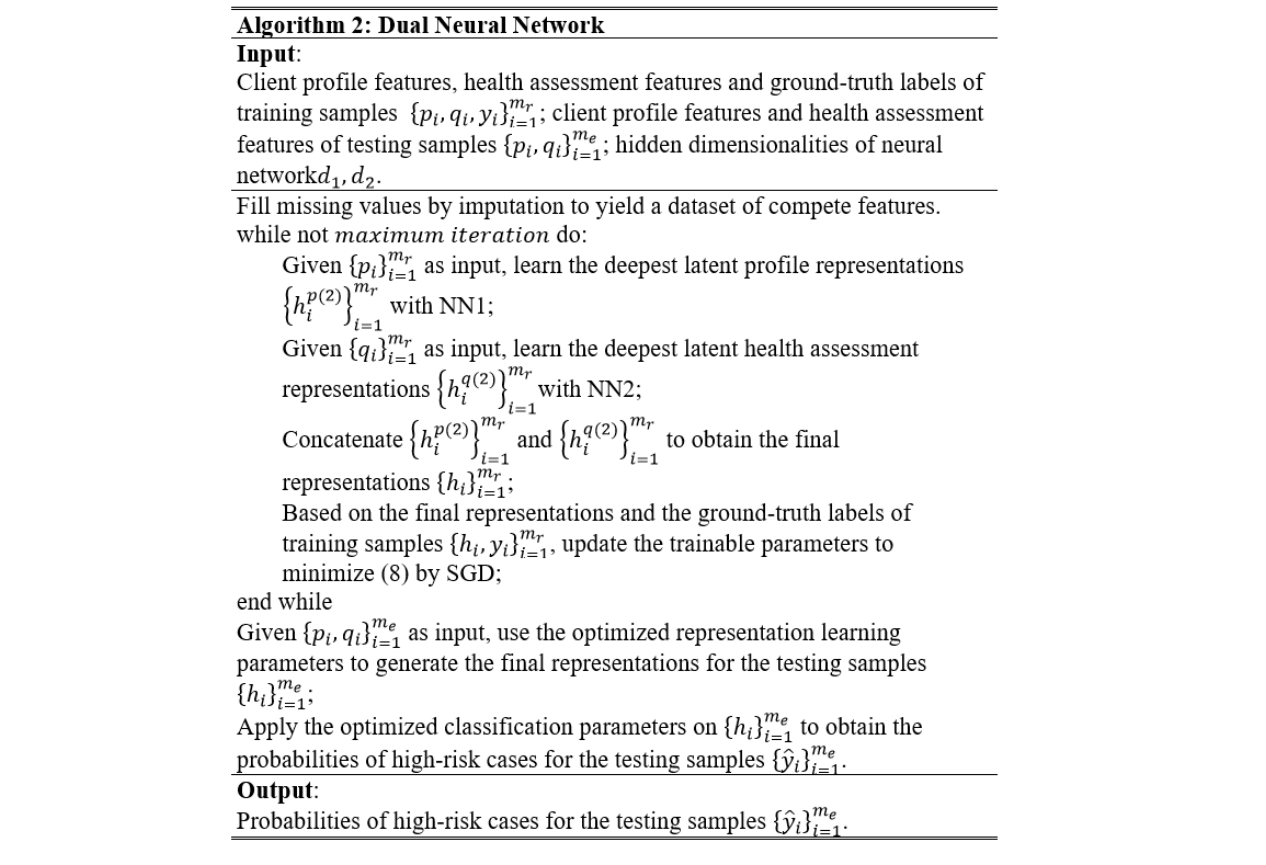
Figure 4. Algorithm of the dual neural network. NN1: neural network 1; NN2: neural network 2; SGD: stochastic gradient